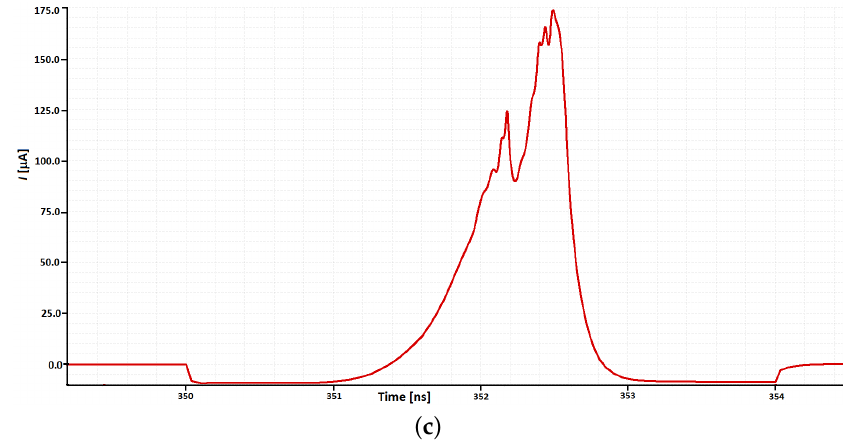
Figure 9. Selected simulation results, illustrating the performance of the designed multi-phase clock, controlled by a simple two-phase external clock: ( a ) selected pulse waveforms for an example case of 10 phases; ( b ) supply current proportional to power dissipation; and ( c ) supply current—the worst